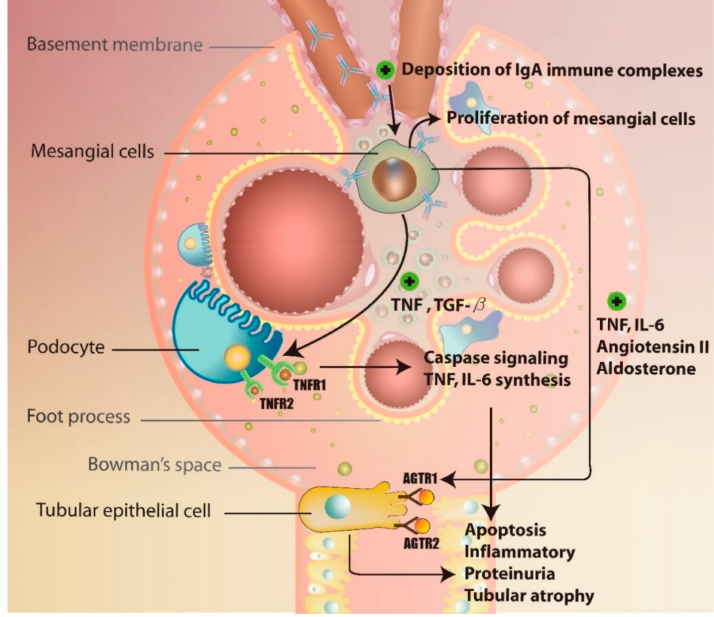
Figure 4. The mechanism of glomerulo-podocytic-tubular crosstalk in